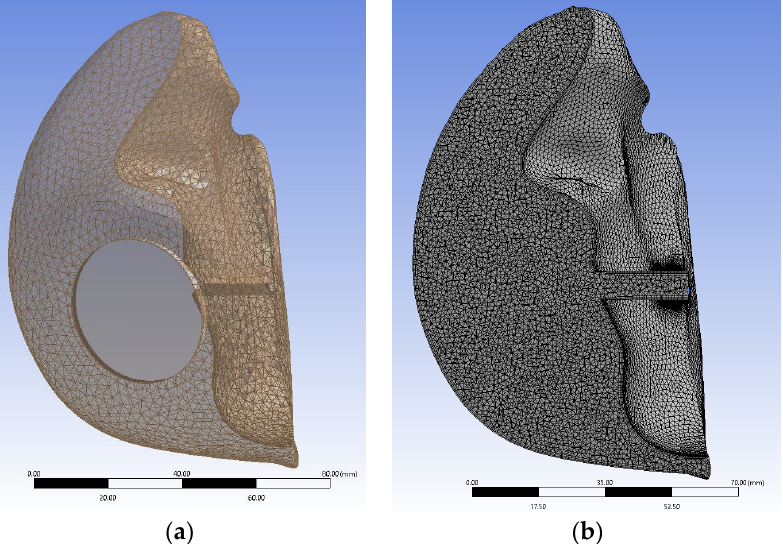
Figure 3. ( a ) Illustration of the examined domain and ( b ) a cross-section of the domain in the vertical plane across the created mesh.